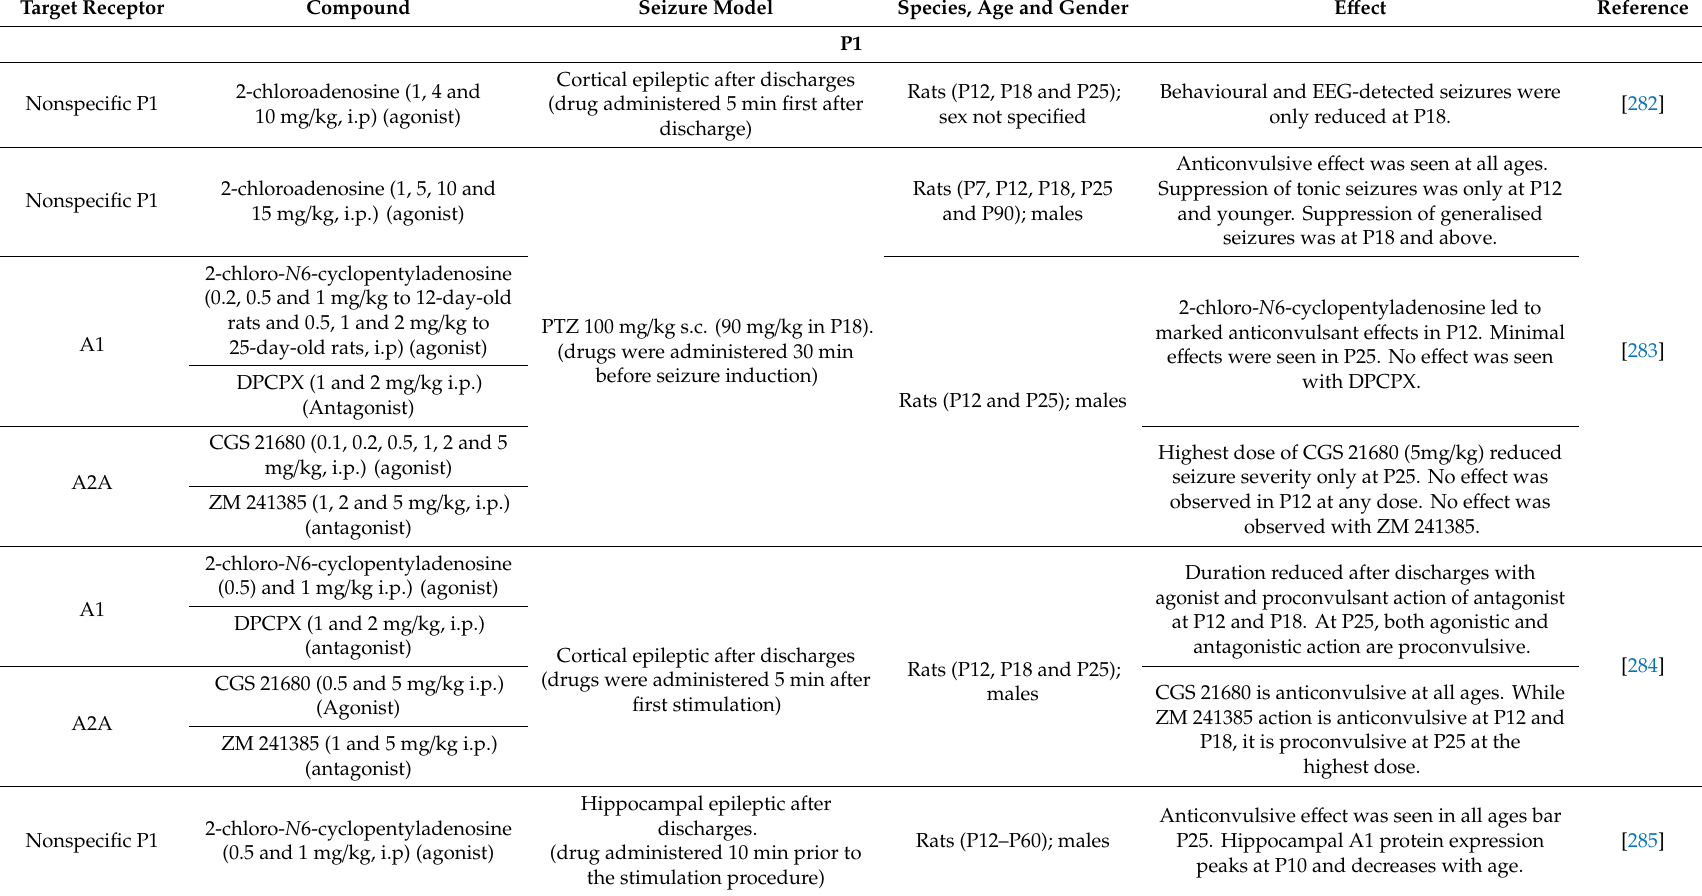
Table 1. Overview of studies investigating purinergic signalling modulating neonatal